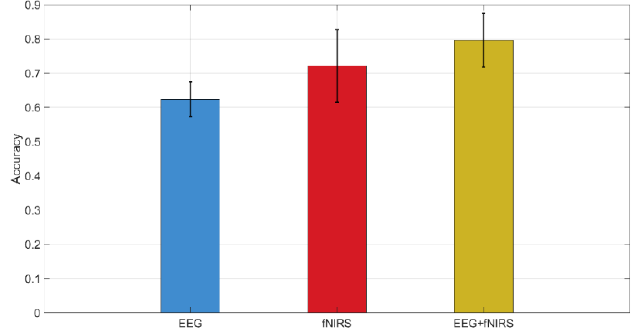
Figure 13. Performances of the proposed fNIRS + EEG method along with EEG only and fNIRS only techniques for all video-content trials as displayed. Whiskers are standard deviation. Table 3. Performance comparison of the proposed method (EEG + fNIRS) and the ones where only EEG or fNIRS employed for all video-content